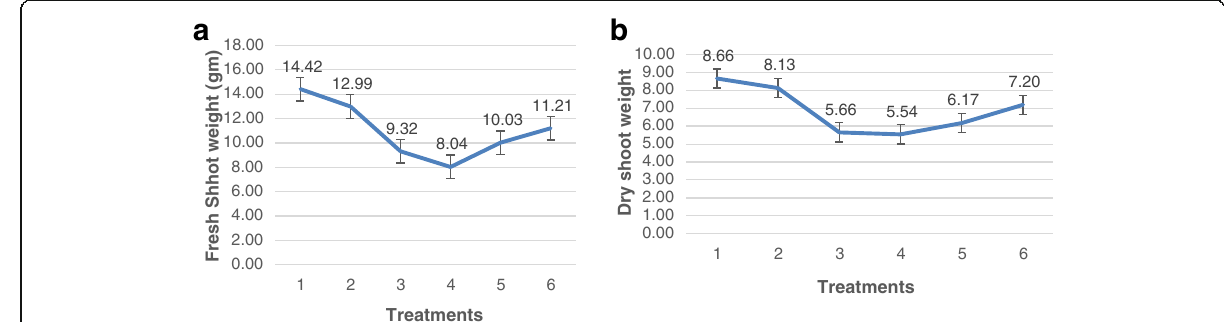
Fig. 3 Effect of soil infection with Trichoderma harzianum , Phythium ultimum , and Phytopthora capsici on tomato fresh shoot weight (g) in a pot experiment ( a ). Effect of soil infestation with T. harzianum on P. ultimum and P. capsici on tomato dry shoot weight (g) in a pot experiment ( b ). 1, uninoculated control (healthy); 2, T. harzianum (alone); 3, inoculated with P. capsici (alone); 4, inoculated with P. ultimum (alone); 5, inoculated of P. capsici with T. harzianum ; 6, P. ultimum with T.